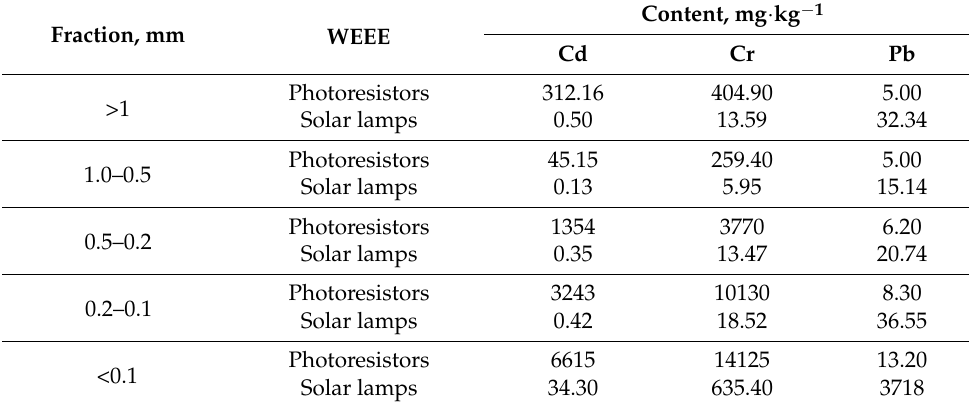
Figure 4. XRD patterns of LCD screen. Table 7. Harmful elements in a different fraction of ground WEEE. Fraction,